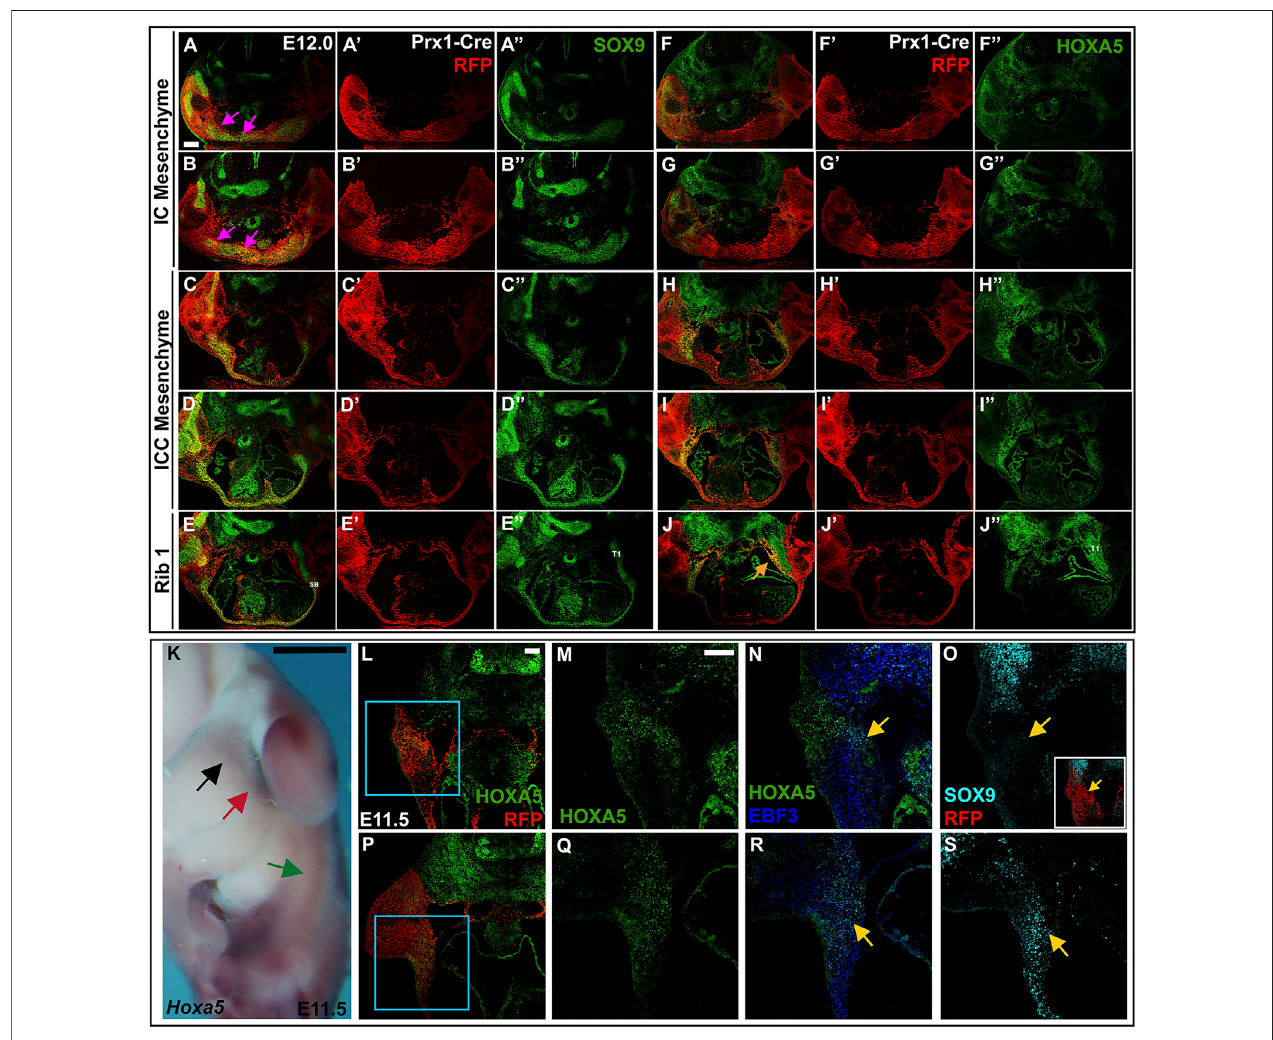
FIGURE8| LPM-derivedHOXA5expressioncanbeseenlaterallyasearlyasE11.5andE12. (A – J ″ ) E12.5Prx1-Cre-RFPembryoinwhichalternatesectionswere labelled for SOX9 (A – E ″ ) or HOXA5 (F – J ″ ) . Images are shown with RFP and either SOX9 (A – E) or HOXA5 (F – J) ; RFP alone (A ′ – E ′ ; F ′ – J ′ ) , or SOX9 (A ″ – E ″ ) or HOXA5 (F ″ – J ″ ) alone.Pinkarrowsin (A,B) indicateSOX9expressionassociatedwithdevelopingclaviclesandICelements. (K) Wholemount insitu hybridizationfor Hoxa5 in an E11.5 embryo. Black arrow indicates LPM expression anterior to the forelimb; red arrow points to LPM expression adjacent to the forelimb; green arrow marks additionalHOXA5expressionthatremainsuntranslated. (L,P) RFPandHOXA5expressioninsectionsthroughanE11.5Prx1-CreRFPembryoatthelevelindicatedin (K) by black arrow (L) , or red arrow (P) . (M,N) expression of Hoxa5 (M) or EBF3 and HOXA5 (N) in the area indicated by blue square in (L) . (O) SOX9 expression in an alternate section of same embryo shown in (L) . (Q,R) expression of HOXA5 (Q) or EBF3 and HOXA5 (R) in area indicated by blue square in (P) . (S) SOX9 expression in an alternate sectionofsameembryoshownin (P) .Yellowarrowin (N,R) indicatesregionofHOXA5andEBF3co-expression.Yellowarrowin (O,S) showscorrespondingregionofSOX9 expression. Inset in (O) shows SOX9 expression in the context of Prx1-Cre-RFP. Scale bar: (A – J) , 200 μ M; (K) , 25 mm; (L – S) , 100 μ M. SB, sternal bar; T1, thoracic rib 1.